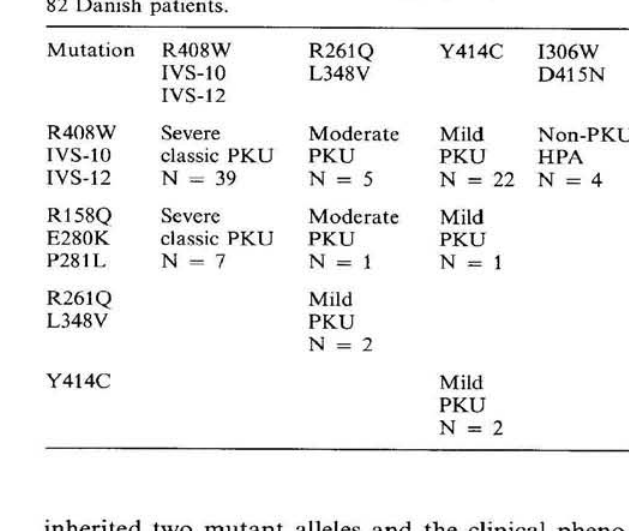
Table 3. Correlation between mutation genotype and different phenotypes of PKU and non-PKU hyperphenylalaninemia in 82 Danish